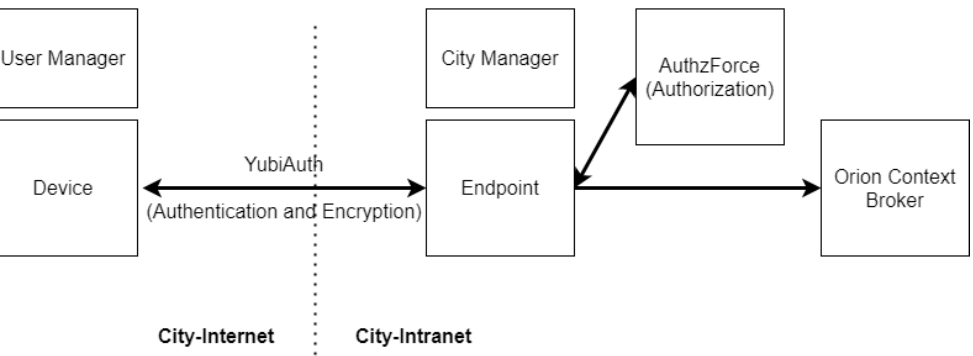
Figure 7. FIWARE integration (Orion